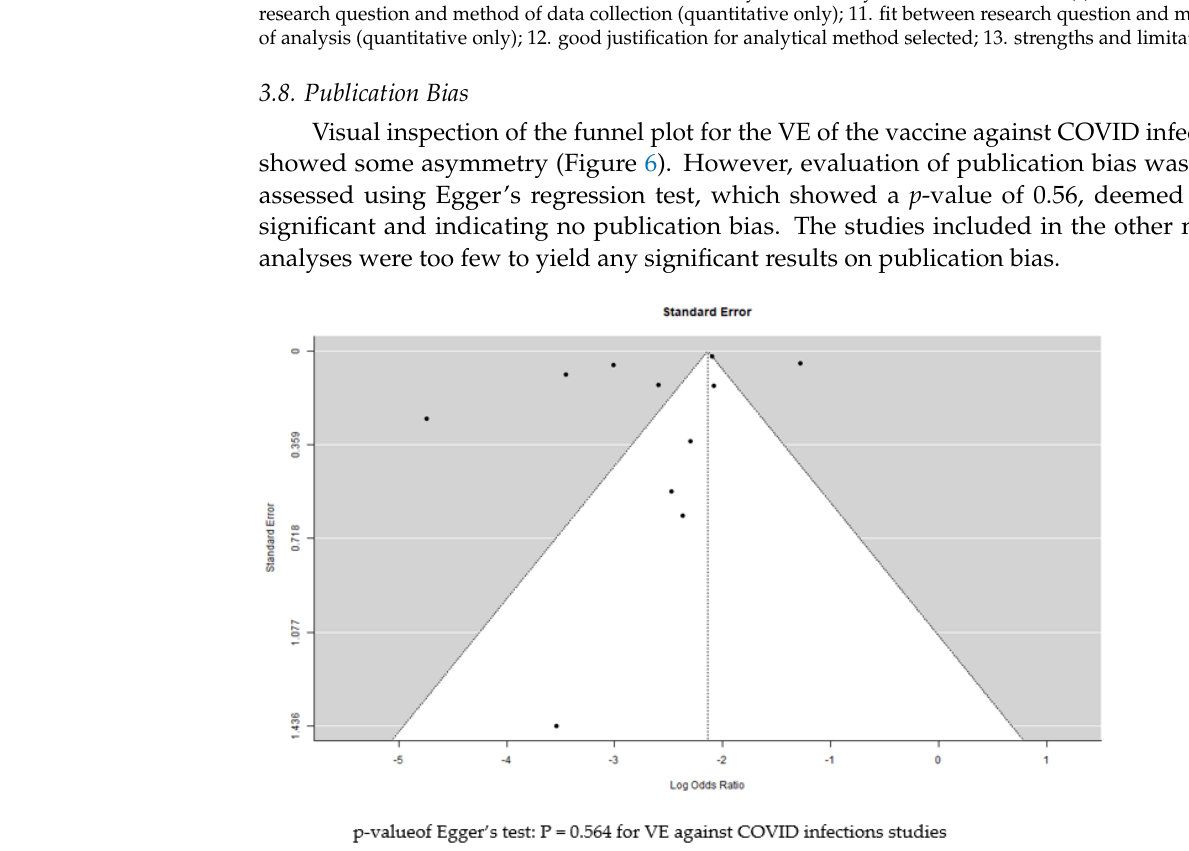
Figure 6. Funnel plot to assess publication bias with Egger’s test—COVID infections. The dots rep- resent individual studies. represent individual